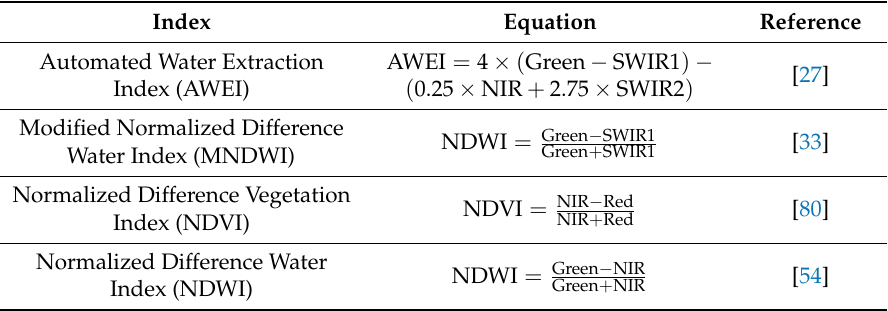
Table 1. Satellite-derived indices used for water features